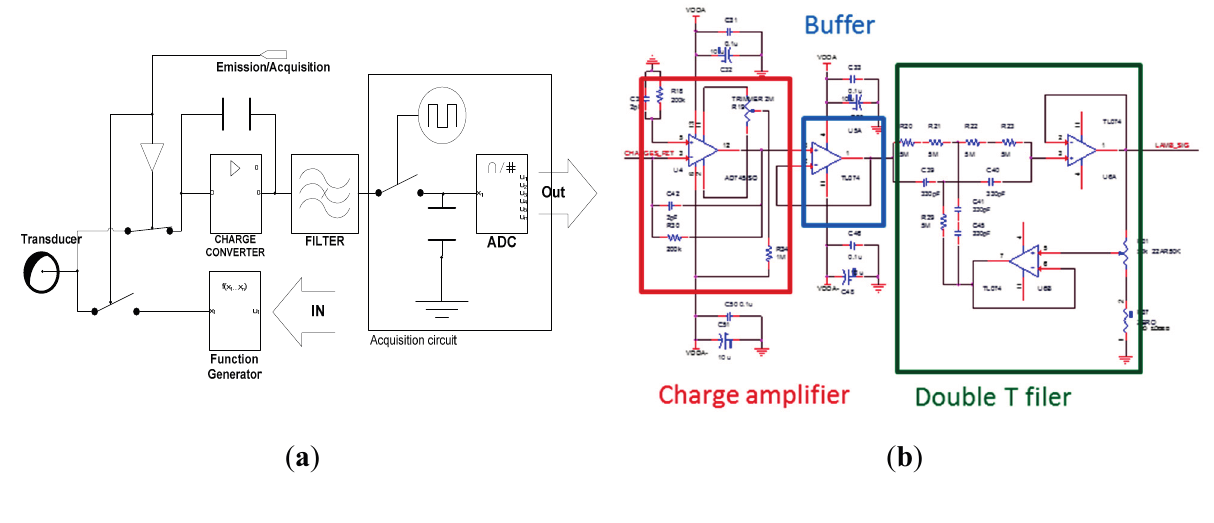
Figure 12. Smart sensor: ( a ) synopsis of the developed electronics; ( b ) analog interfacing circuit; ( c ) photo of the developed